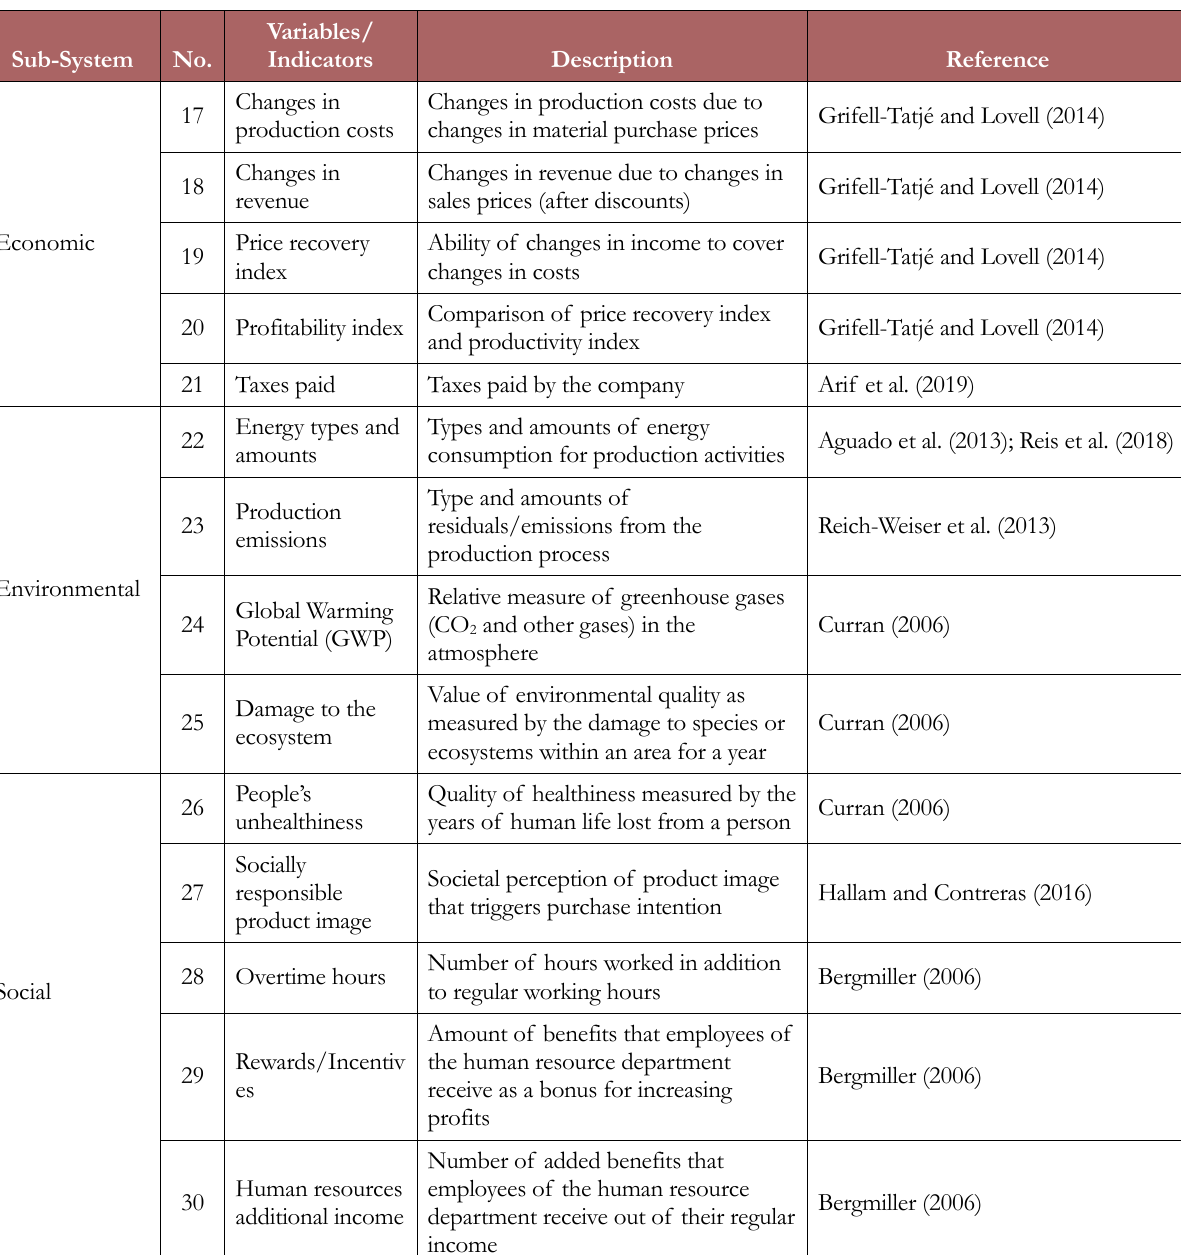
Table 1. Main Variables in Sustainable Cosmetics